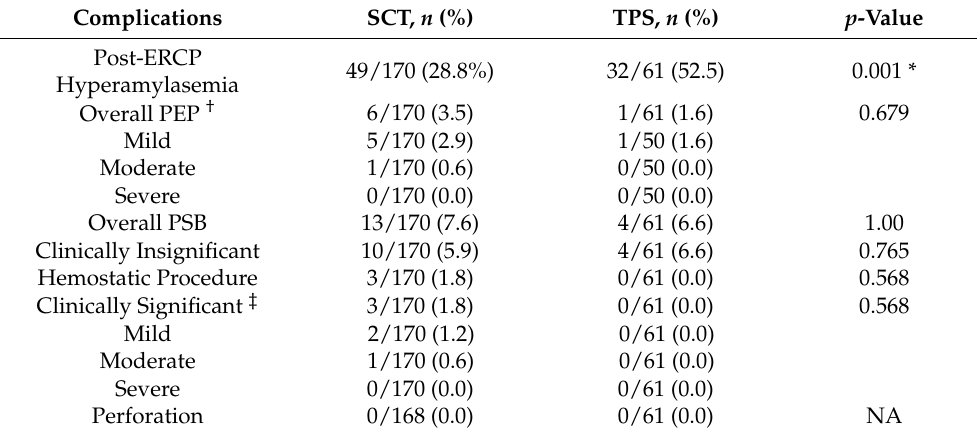
Table 2. Complication rates of SCT and